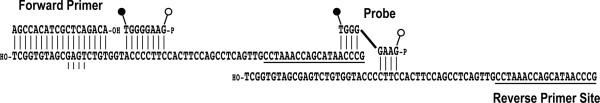
Proposed mechanism of extraordinary fluorescence growth with LNA hydrolysis probe detection. The example shown is the GAPDH amplicon (see Materials and Methods) which e.g. had an EA0 of 2.33 with hydrolysis probe and 2.00 with SYBR green detection. The diagram shows forward primer, LNA hydrolysis probe with 5' fluorophore (filled circle) and 3' quencher (open circle), and the entire amplicon antisense strand, with reverse primer sequence underlined. A 3' phosphate (P) prevents elongation of the probe.